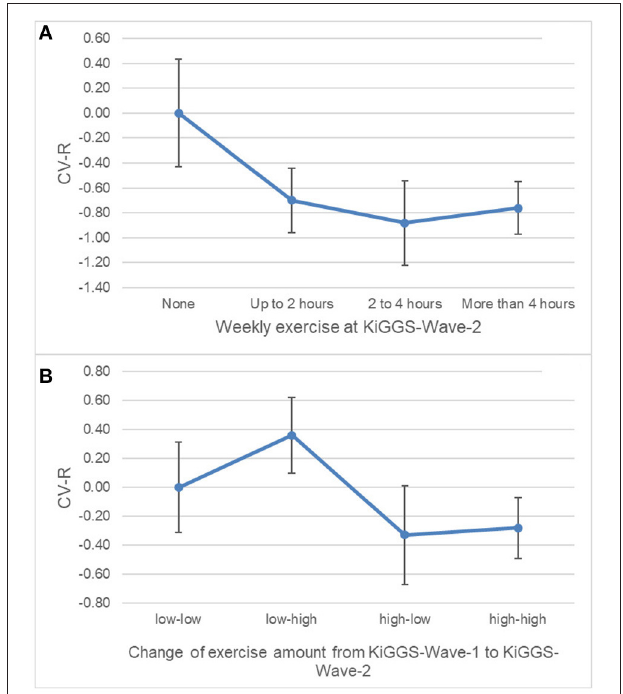
FIGURE 2 | Margin plots demonstrating associations of the cardiovascular risk index (CV-R) with cross-sectional (A) and longitudinal (B) volumes of exercise. CV-R is significantly lower with higher cross-sectional and longitudinal volumes of exercise. “None” set as reference. Weighted estimations from linear regression; n = 2,893. Vertical bars = 95%–confidence intervals. Models adjusted for sex and age.